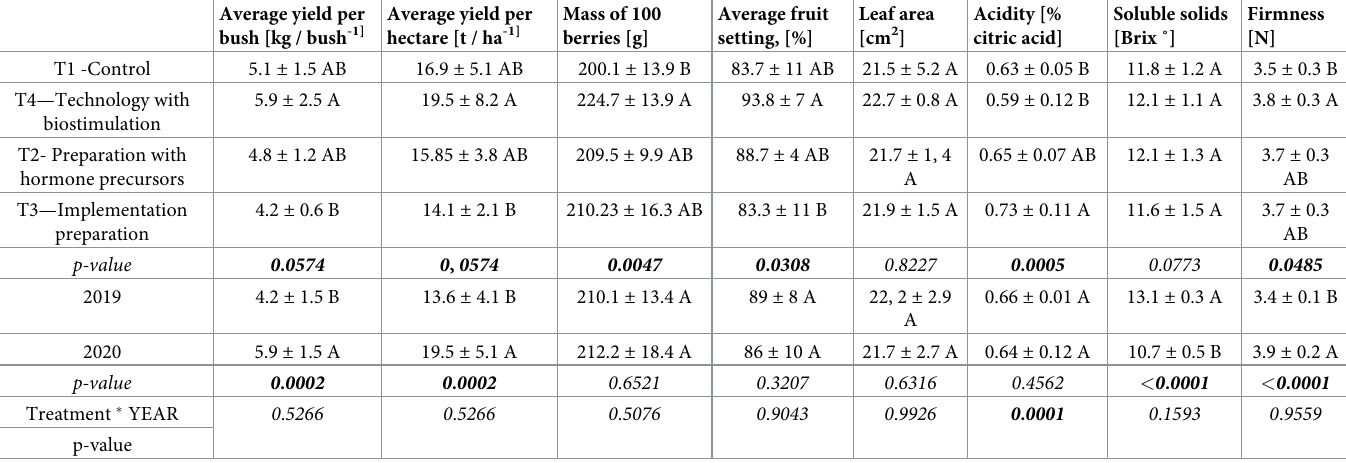
Table 3. Influence of fertilization technology on the yield and quality of ´Bluecrop` highbush blueberry.